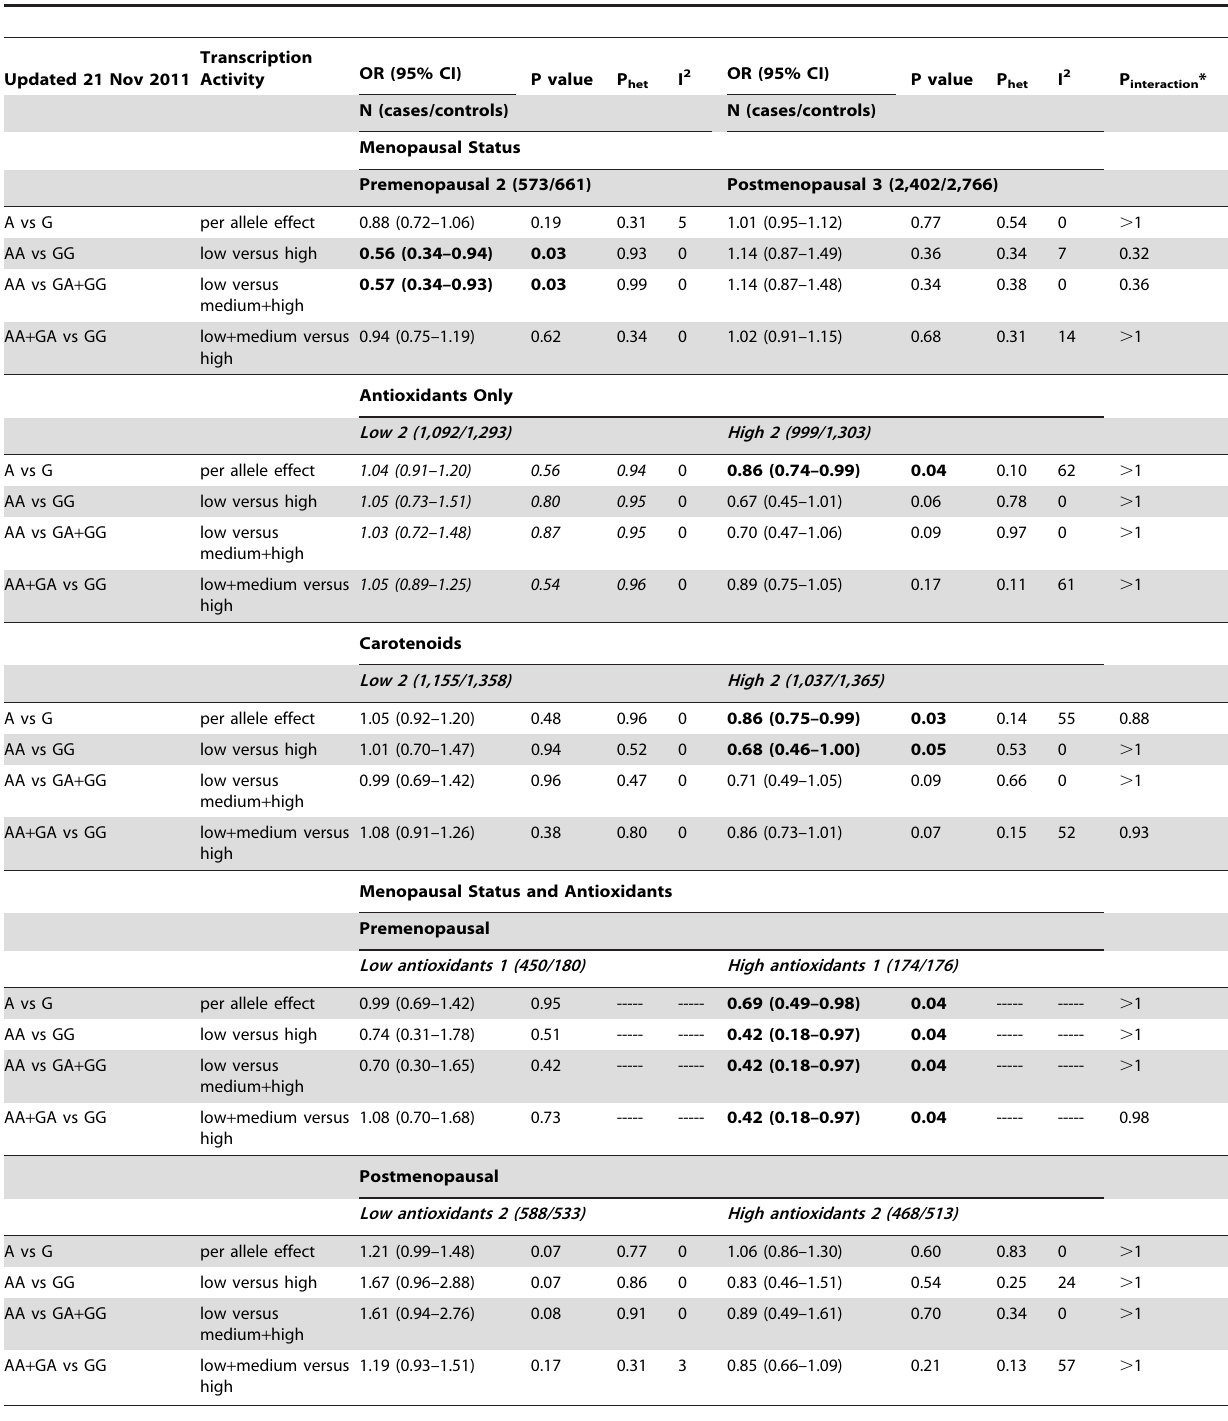
Table 4. Results of the meta-analysis for MPO-G463A polymorphism and breast cancer